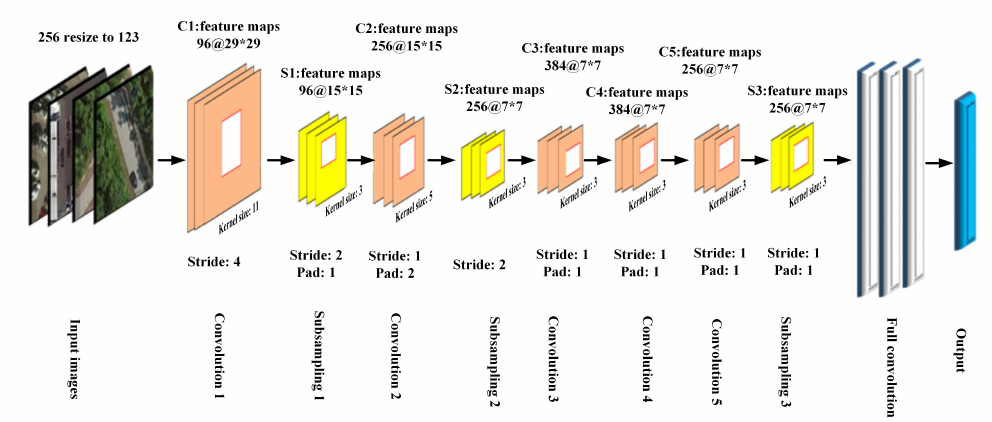
Figure 11. AlexNet model parameter settings in RSI-CB ("96@29*29"means there are 96 feature maps of 29 × 29 pixels. The “Stride” and “Pad” are the parameter of